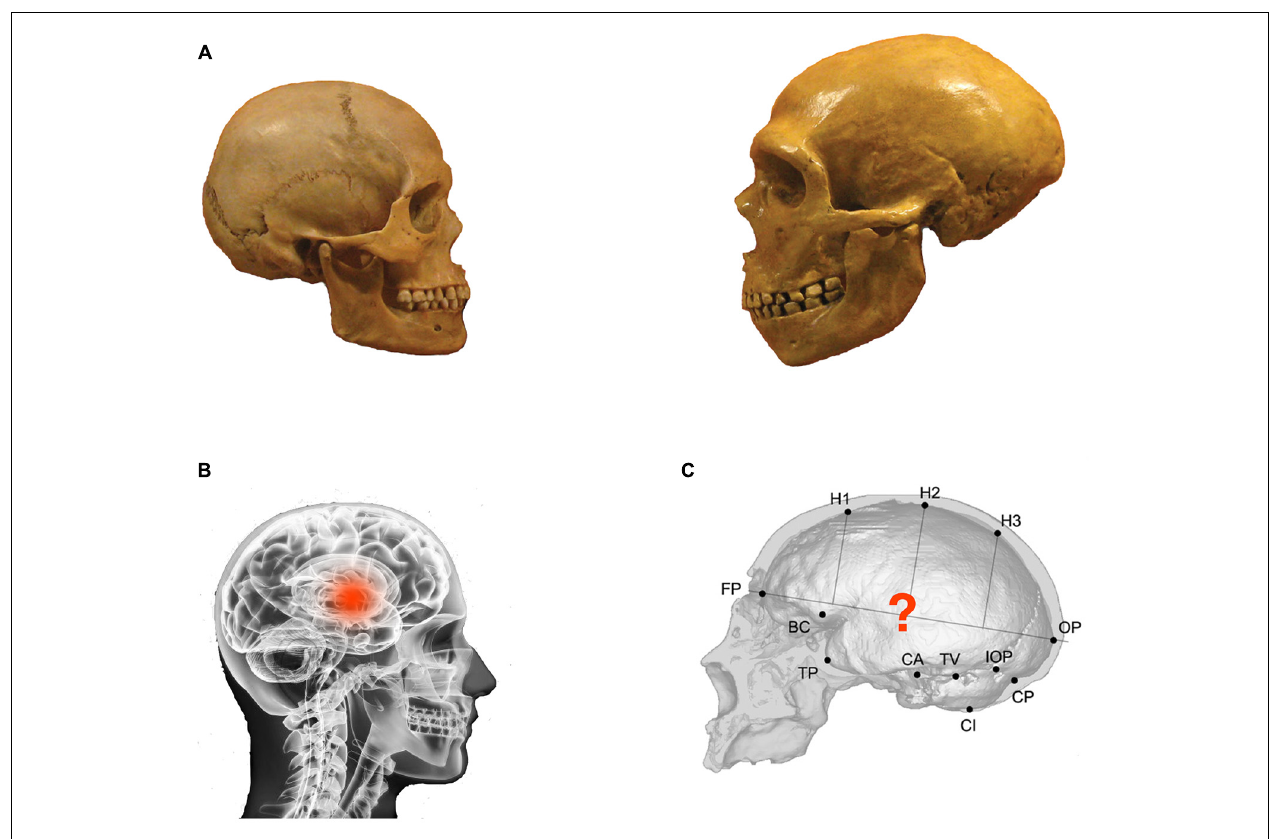
FIGURE 1 | Illustration of the hypothesis. (A) Observable skull differences between anatomically modern human (left) and Neanderthal (right). (B) Identification of the strategic position of the thalamus in a modern human